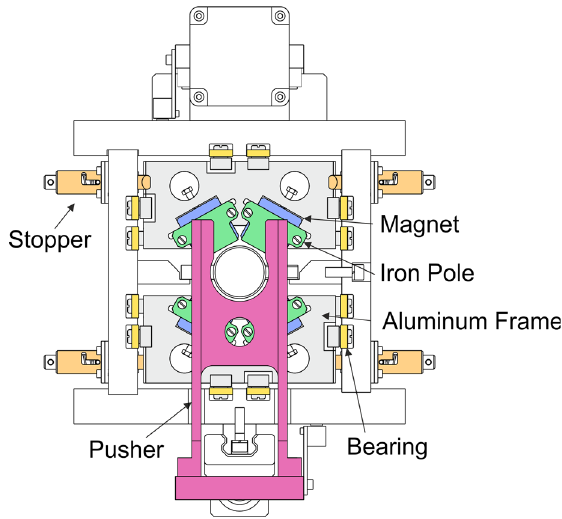
FIG. 21. Undulator mechanical design front